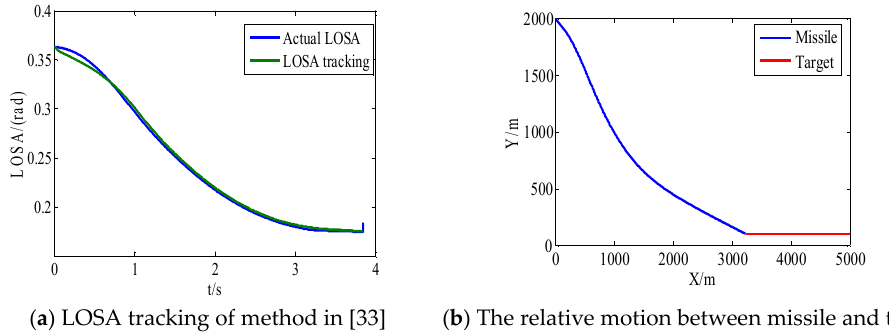
Figure 8. Method in Reference [33].